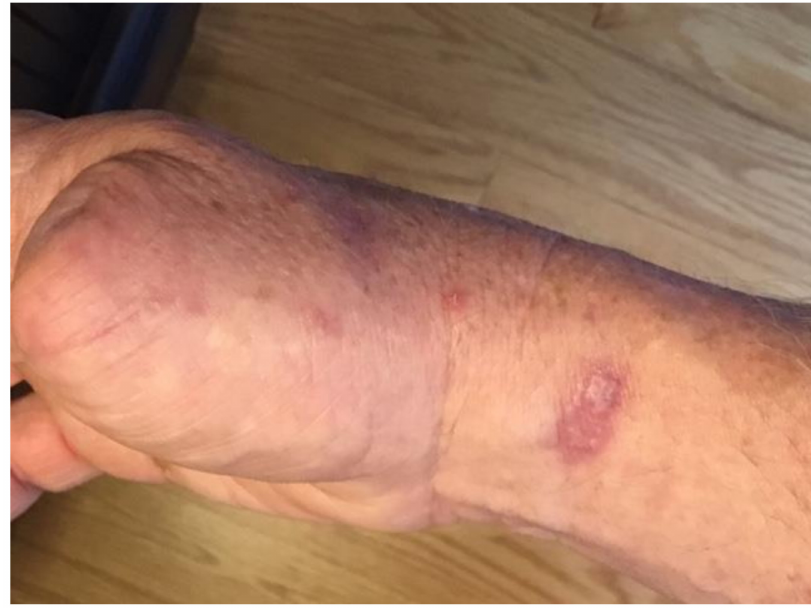
Figure 2. Cutaneous metastasis of invasive porocarcinoma present on right wrist, before interleukin (IL)-2 injection